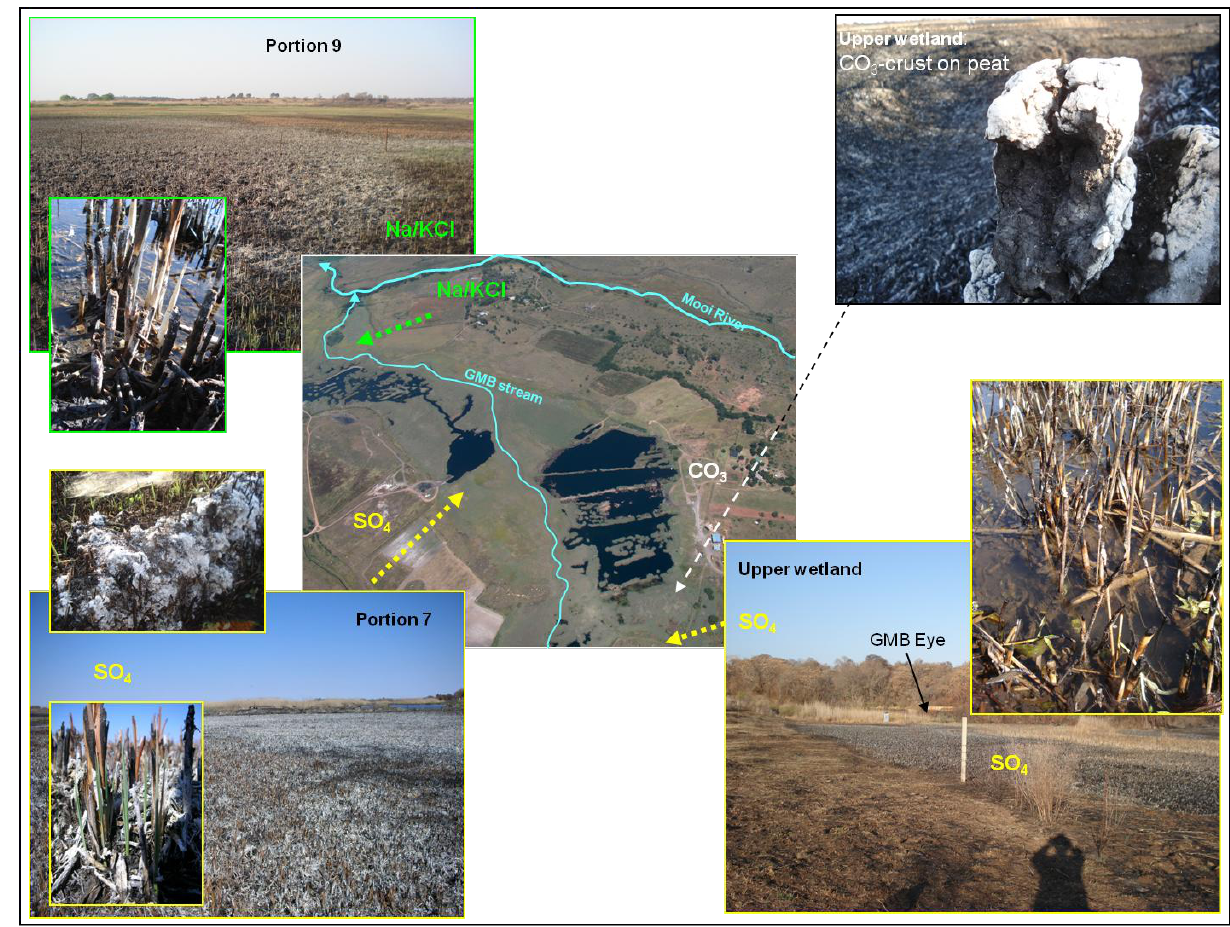
Figure 9. Examples of salt crusts of different mineral composition as observed during the dry winter month of August 2007 at four different sites of the Gerhard Minnebron